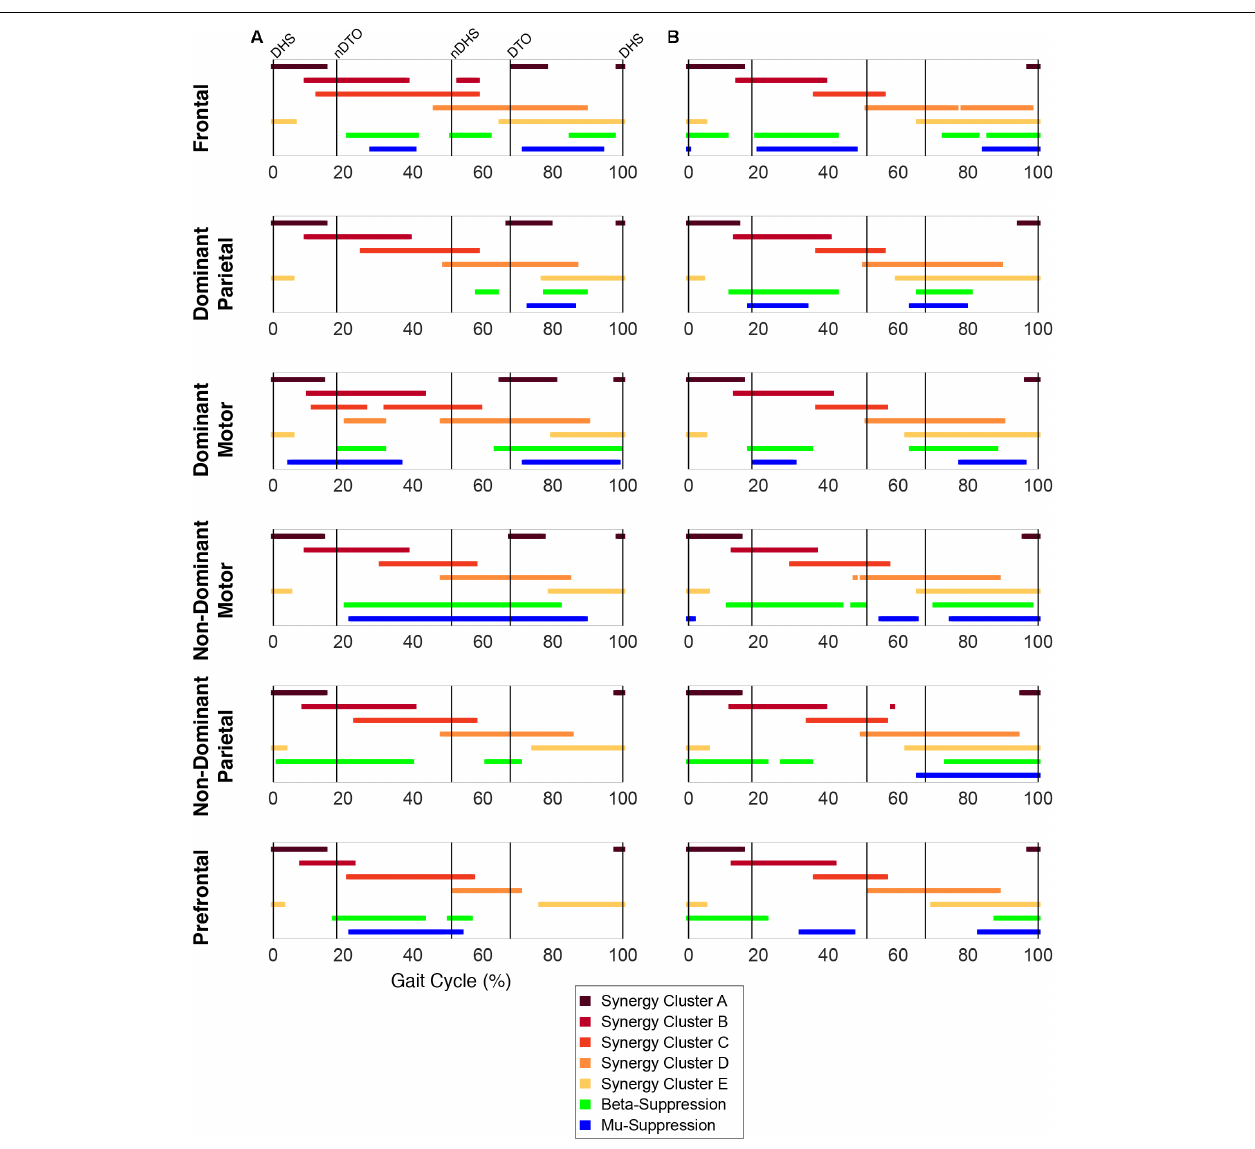
FIGURE 5 | Overlap between synergy and cortical component activity. Significant periods of synergy activation plotted with mu- and beta-suppression throughout the gait cycle for each cortical cluster in (A) TD and (B)